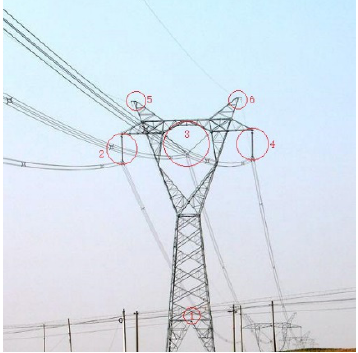
Figure 7. AC single ‐ return linear transmission tower